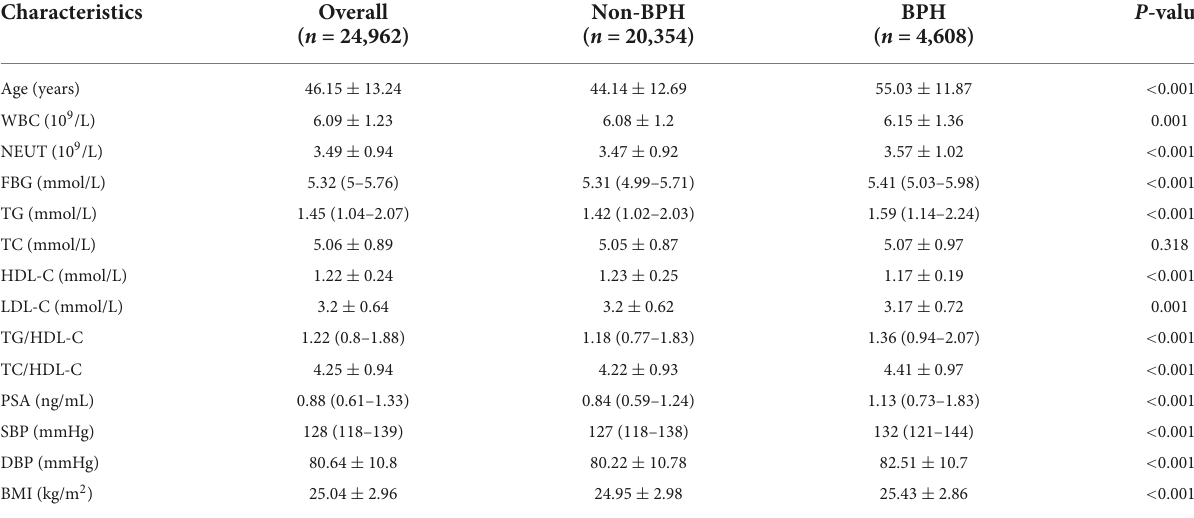
TABLE 1 Clinical and biochemical parameters of the study population.